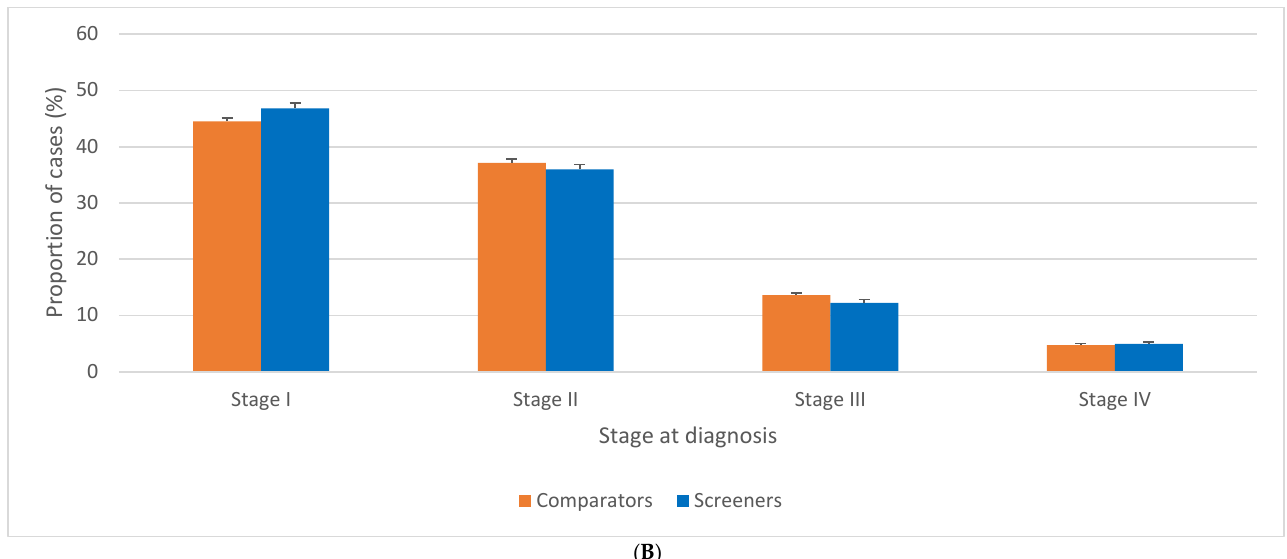
Figure 6. ( A ). Stage-specific distribution of female breast cancer cases by jurisdictional screening status, ages 40 to 49 years, Canada excluding Quebec, 2010 to 2017. ( B ). Stage-specific distribution of female breast cancer cases, ages 50 – 59 years, by jurisdictional screening status for women 40 – 49 years, Canada excluding Quebec, 2010 to 2017. Note: Quebec is excluded because cases diagnosed in Quebec from 2011 onward had not been submitted to the Canadian Cancer Registry. Screeners: Alberta, British Columbia, Nova Scotia, Northwest Territories, and Prince Edward Island; Comparators: Manitoba, New Brunswick, Newfoundland and Labrador, Nunavut, Ontario, Saskatchewan, Yukon. Source: Canadian Cancer Registry (1992 to 2018) at Statistics Canada [42,44]; provincial and territorial screening practices [49,50].